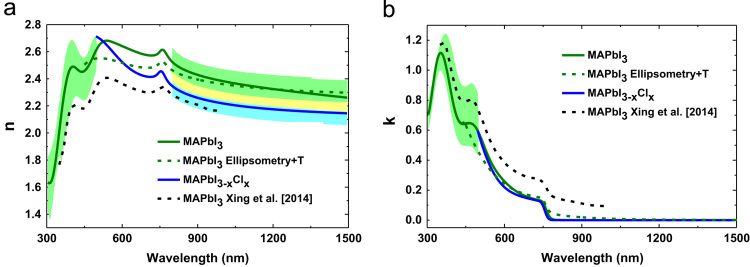
The modelled (a) refractive index n and (b) extinction coefficient k of CH3NH3PbI3 and CH3NH3PbI3−xClx thin films compared to results reported by Xing et al. [8] (dashed line).